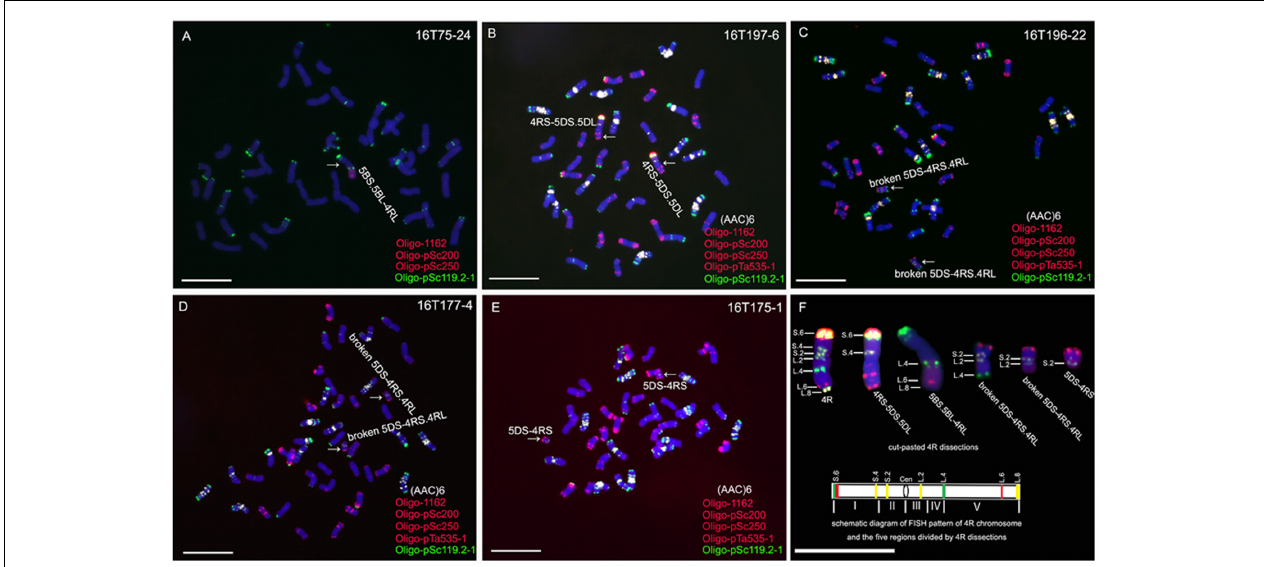
FIGURE 2 | ND-FISH analysis using probes Oligo-pSc119.2-1 (green), Oligo-pTa535-2 (red), Oligo-pSc200 (red), Oligo-pSc250 (red) and (AAC) 6 (white) to identify 4R Ku dissection lines. (A) 5BS.5BL-4RL translocation line 16T75-24. (B) 4RS-5DS.5DL translocation line 16T197-6. (C) Line 16T196-22 contains broken 5DS-4RS.4RL chromosomes. (D) Line 16T177-4 contains broken 5DS-4RS.4RL chromosomes. (E) Line 16T175-1 contains 5DS.4RS small translocation chromosomes. (F) Cut-pasted 4R Ku dissections and the schematic diagram of FISH pattern of the 4R Ku chromosome. The FISH signals are numbered. In the schematic diagram, five regions of the 4R Ku chromosome were indicated by Roman numerals, green bands represent Oligo-pSc119.2-1 signals, red bands represent Oligo-pSc200 and Oligo-pSc250 signals, yellow bands represent (AAC) 6 signals, and ‘Cen’ represents centromere. Chromosomes were counterstained with DAPI (blue). Scale bar is 10 µ m.